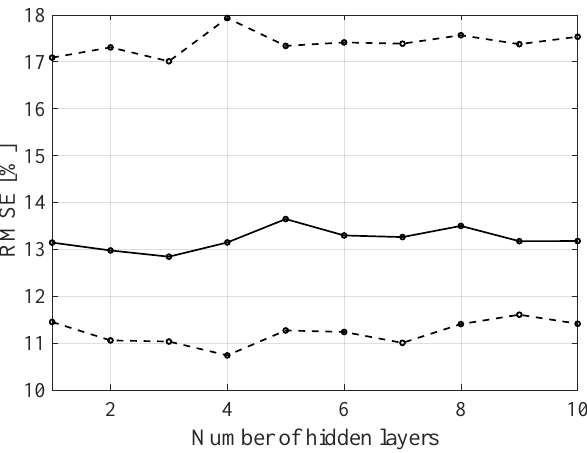
Figure 22. The RMSE BLER as a function of the hidden layers number.